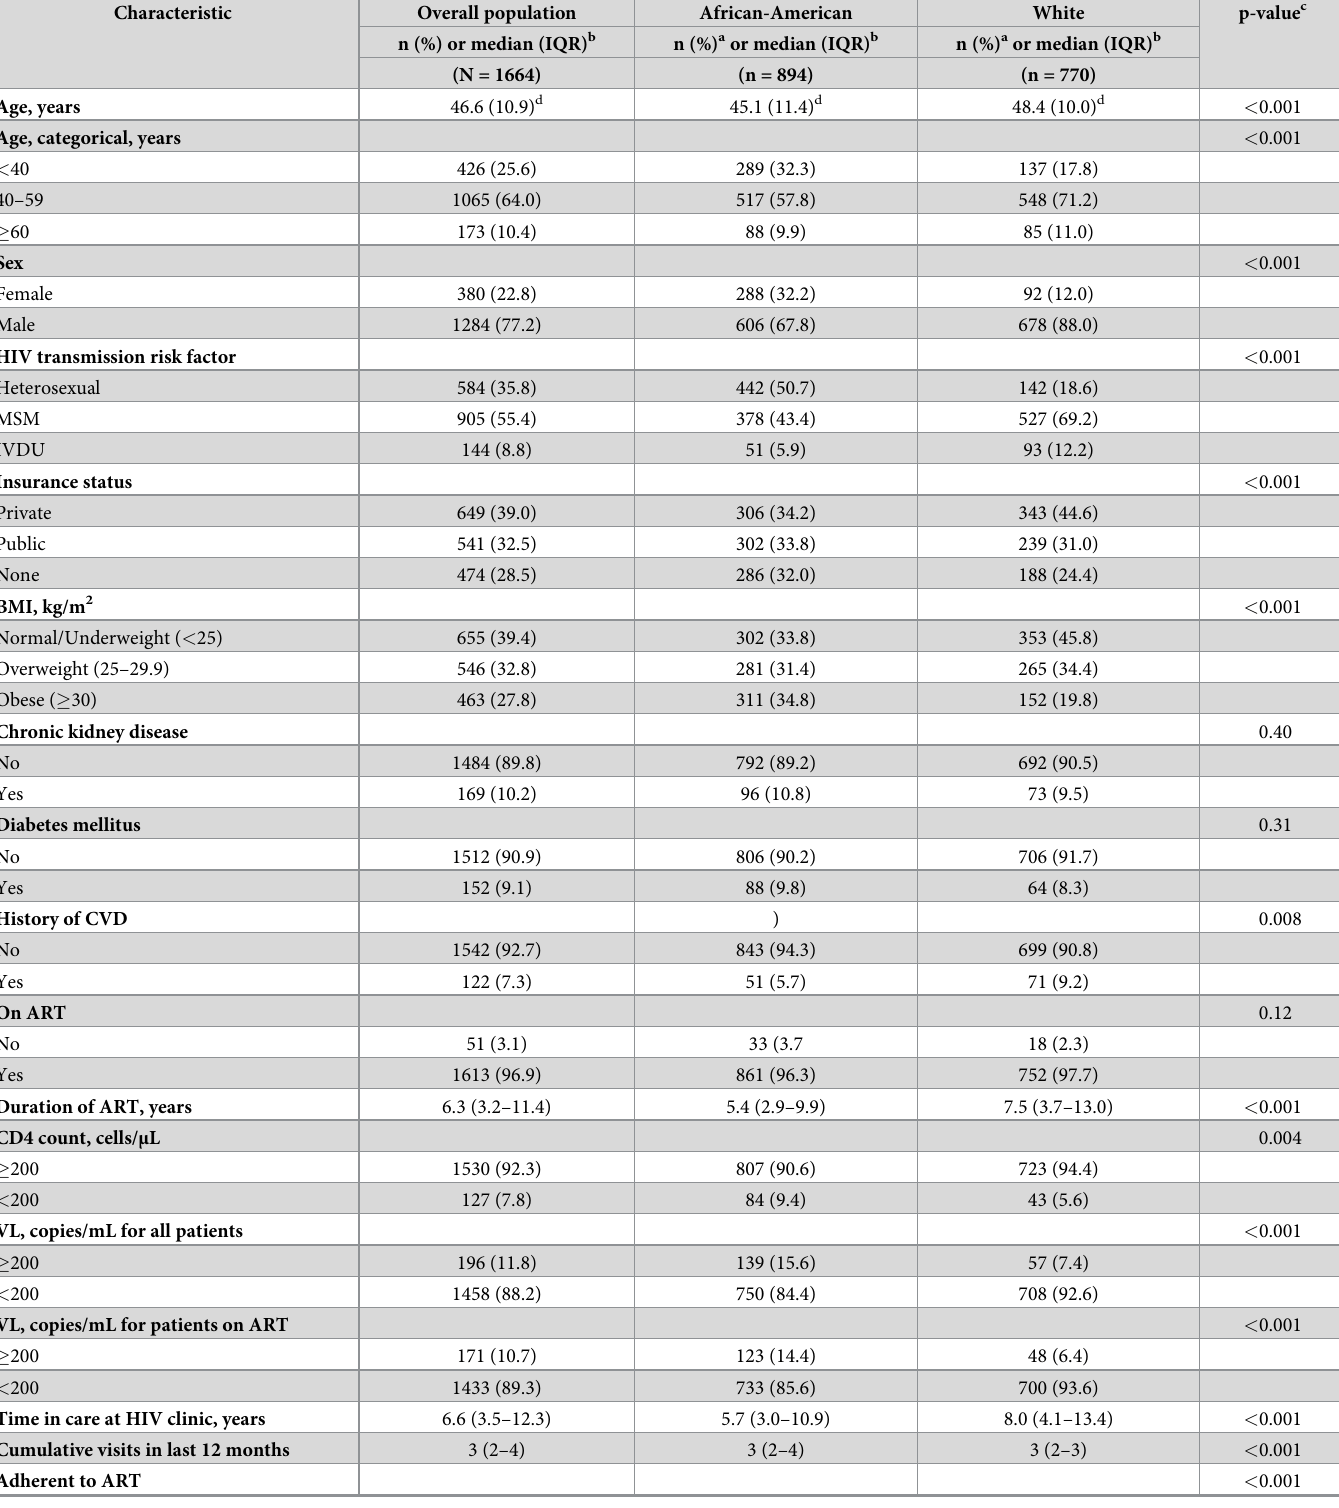
Table 1. Characteristics of HIV-infected patients attending the UAB 1917 HIV Clinic in 2013 included in the analyses of hypertension